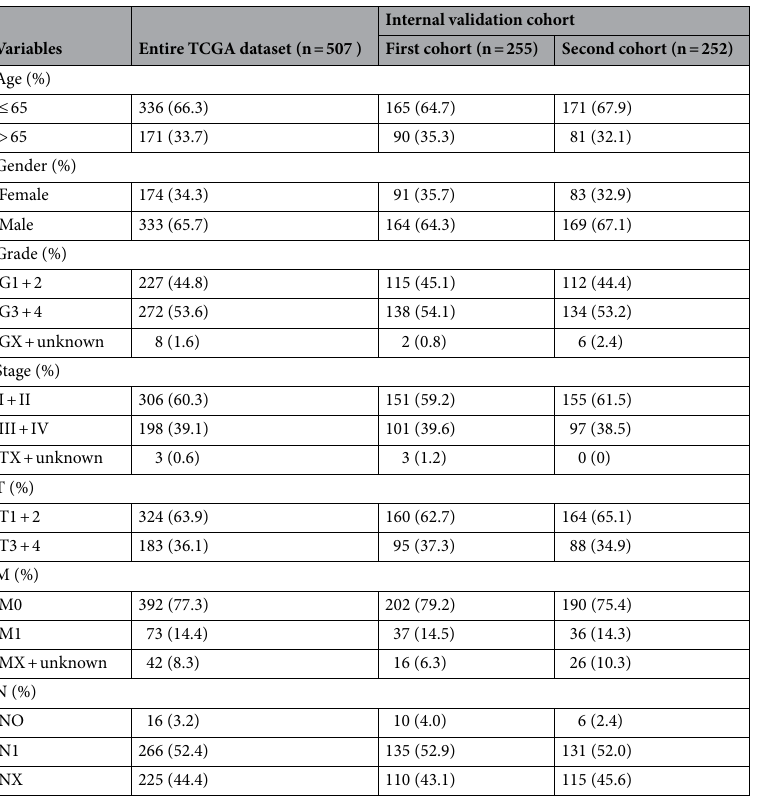
Table 1. Clinical characteristics of the different cohorts of patients. T, tumor; M, metastasis; N, lymph